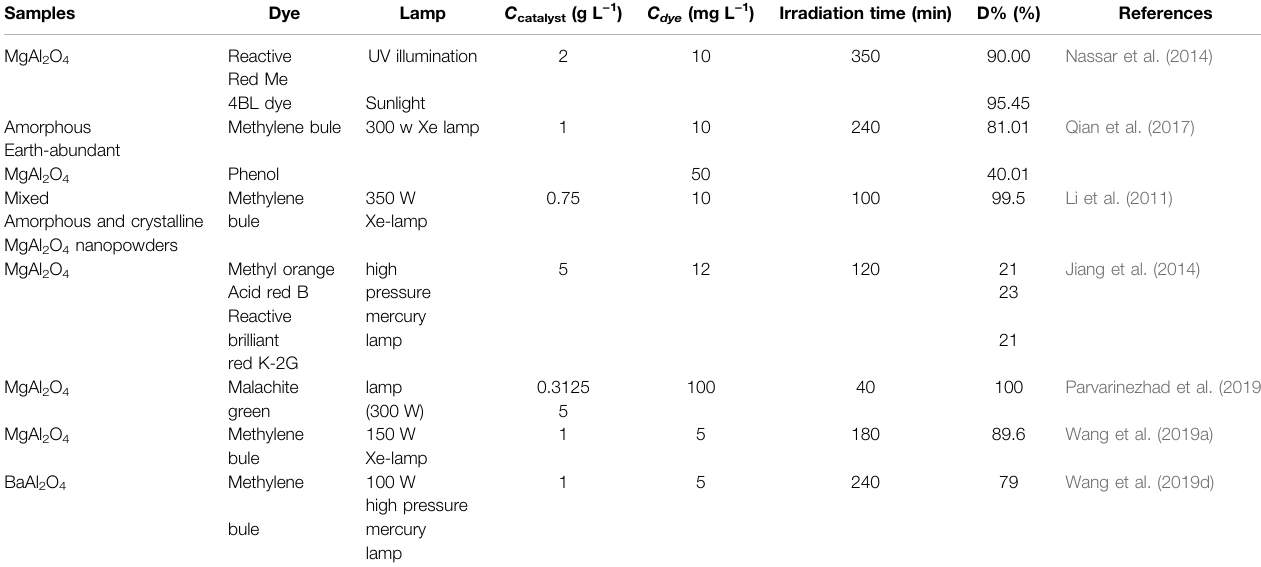
TABLE 2 | The photocatalytic activity of MAl 2 O 4 photocatalyst. Samples